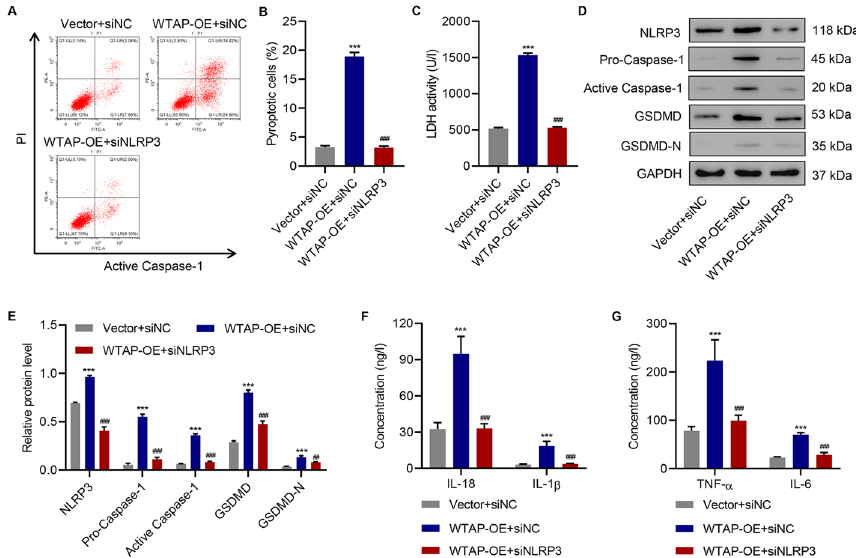
Fig. 5 WTAP overexpression promotes cell pyroptosis and pro-inflammatory factor release in HK-2 cells by targeting NLRP3. A , B Cell pyroptosis; C lactate dehydrogenase activity; D , E expression of NLRP3, pro-caspase-1, active caspase-1, GSDMD, and GSDMD-N; ( F , G ) release of IL-18, IL-1β, TNF-α, and IL-6 in HK-2 cells with or without WTAP overexpression and NLRP3 knockdown ( n